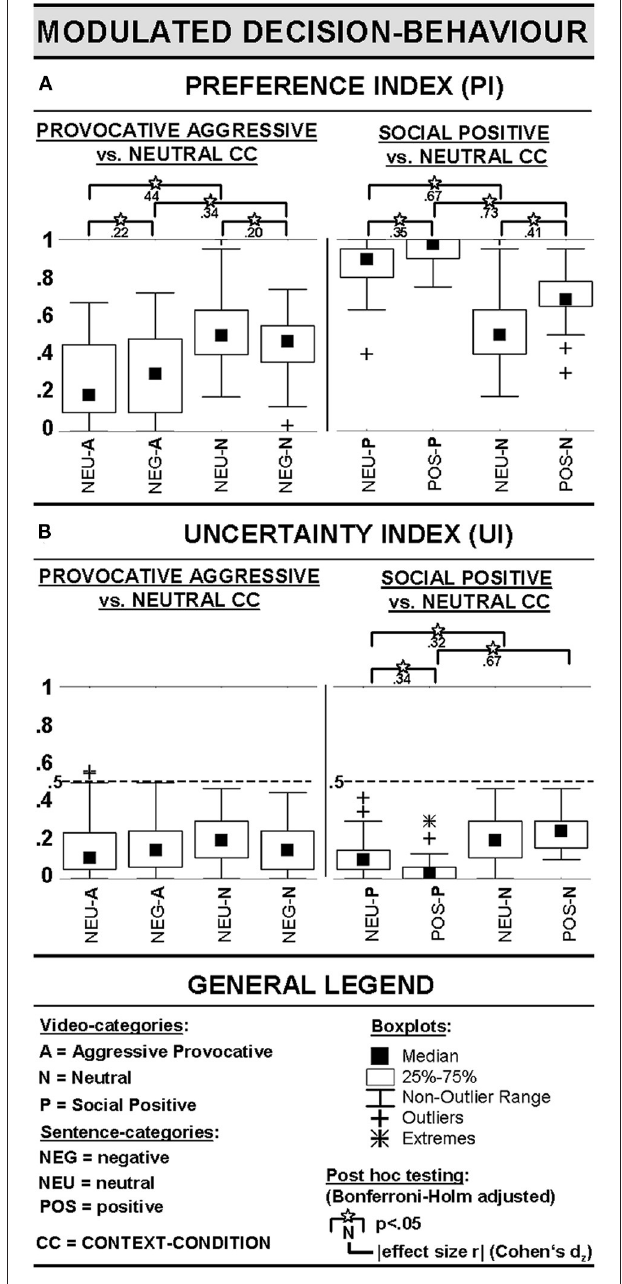
FIGURE 3 | Preference Index (PI, A ) and Uncertainty Index (UI, B